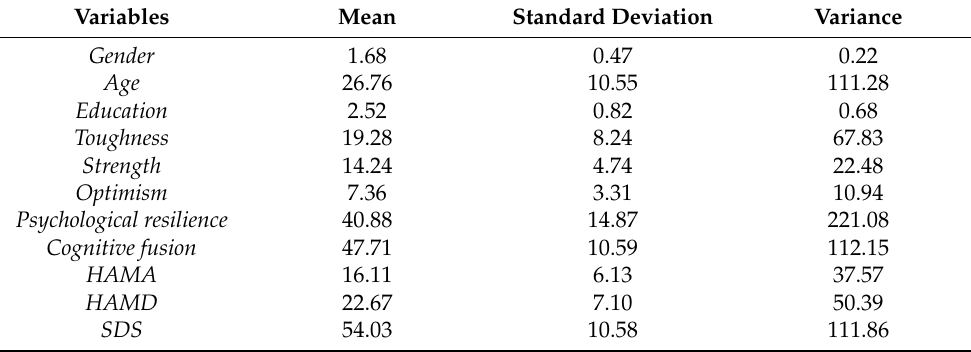
Table 1. Descriptive statistics of the variables (N = 156).